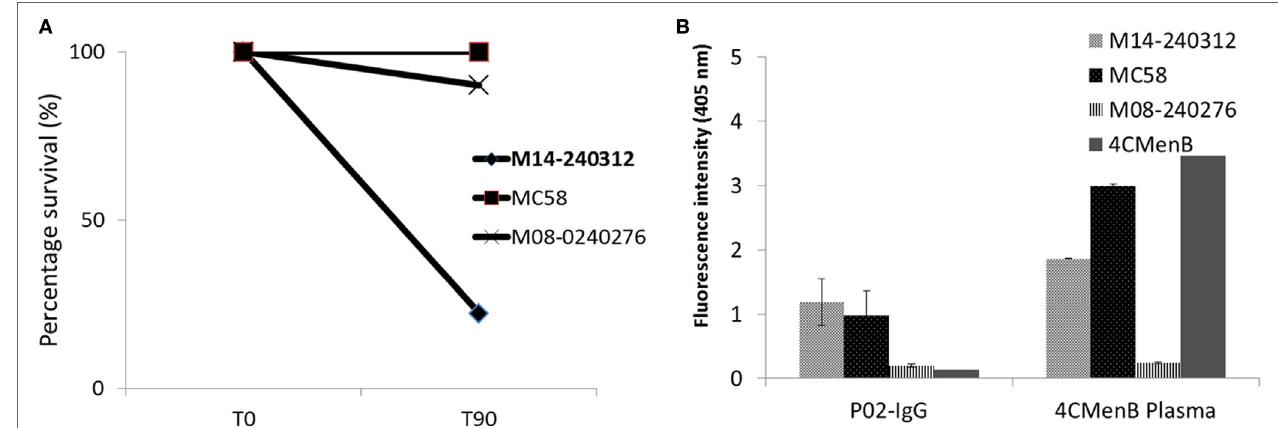
FigUre 2 | Qualitative analyses of patient SM-P02’s adaptive immune response to a MenB infection. (a) Serum bactericidal response of SM-P02 plasma IgG (final assay concentration of 192 µg/ml) to the infecting MenB strain, M14-240312. (B) Reactivity of SM-P02 plasma IgG to MenB strains and 4CMenB in ELISA. Cells normalized to OD600 of ~0.5 or 1 µg of 4CMenB were used as antigen in ELISAs (duplicate wells). Error bars represent SEM. Data were obtained from three biological assay replicates ( n =